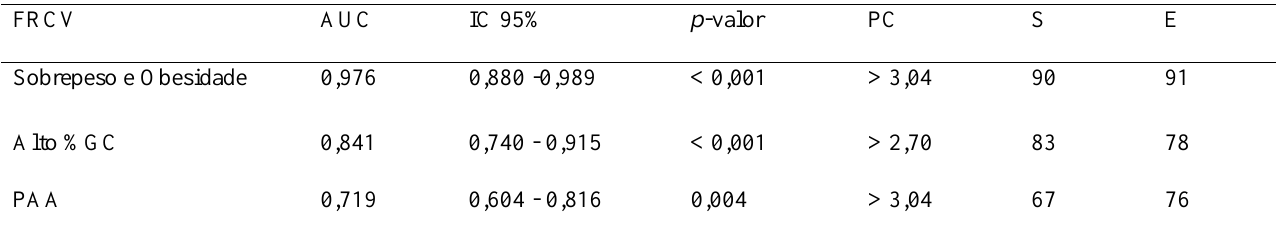
Tabela 2. Predição de fatores de risco cardiovasculares, em meninas por meio do NAF.